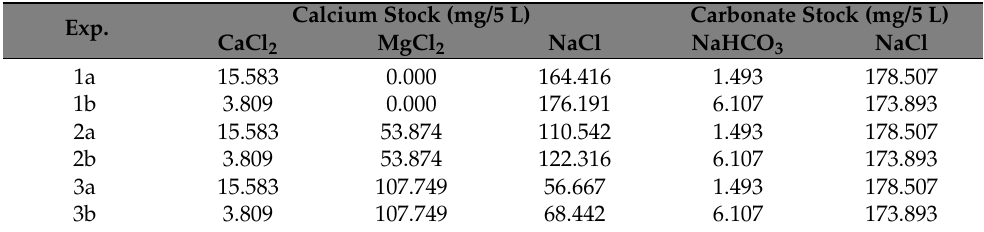
Table A2. The quantity of compounds (mg/5 L) added to the stock solution to obtain the experimental parameters outlined in Table